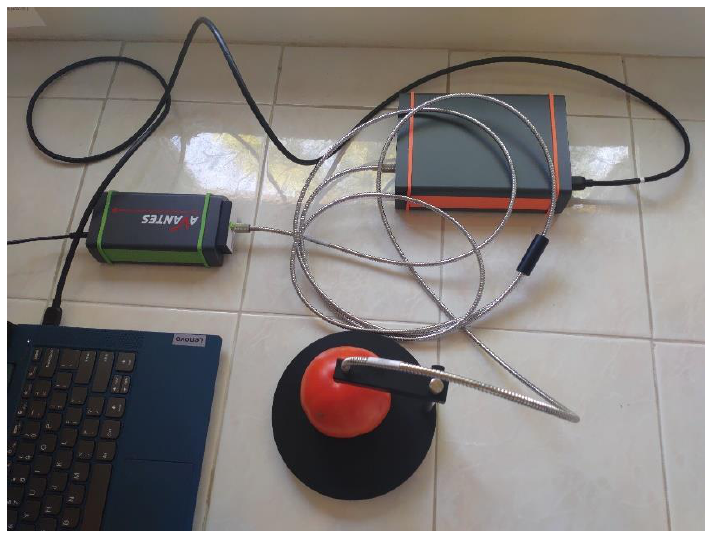
Figure 2. The fluorescence spectroscopy setup for the tomato sample measurements. The resolution of the spectrometer was 0.09 nm. The useful fluorescence signal was measured in a direction 180 ◦ below the excitation radiation. The laser diode used had a relatively wide spectral radiation width (30–40 nm) and the angular distribution of the radiation was +/ − 30 ◦ . The sensitivity of the spectrometer was in the range of 200 nm to 1200 nm and the resolution was δλ = 5 nm. Using the spectral installation based on fluorescent signals, the measurements of the emission spectrum and the spectrum of the excitation source were possible. The photodetector of the CMOS type, model S9132, was used for the specific circuit. Model S9132 was chosen because of the possibility of detecting emission radiation from a tomato sample with a very low loss of water content. The laser radiation was removed from the source and fell on the sample. After the sample fluoresces, the emission signal fell on a U-shaped optical fiber with a numerical aperture of 0.22, a core diameter of 200 µ m, and a step-index of the refractive index. In the spectrometer, the light signal was converted to electrical-digital via a USB 2.0 wire, then downloaded to a computer with AvaSoft8 software, and finally exported to Excel. The discriminative models were built based on the fluorescence data to distinguish the uninoculated and yeast-inoculated tomato samples. The schematic approach to data acquisition and analysis is shown in Figure